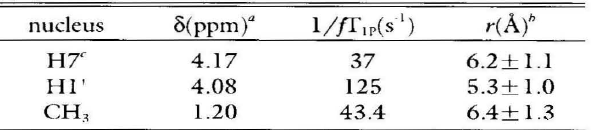
Table 1. Calculated distances from Co(Il) to observable protons of BH2 in the [THI-Co(IJ) . BH2 . Phe] complex nucleus 8(ppm)" l / /T,p(s')